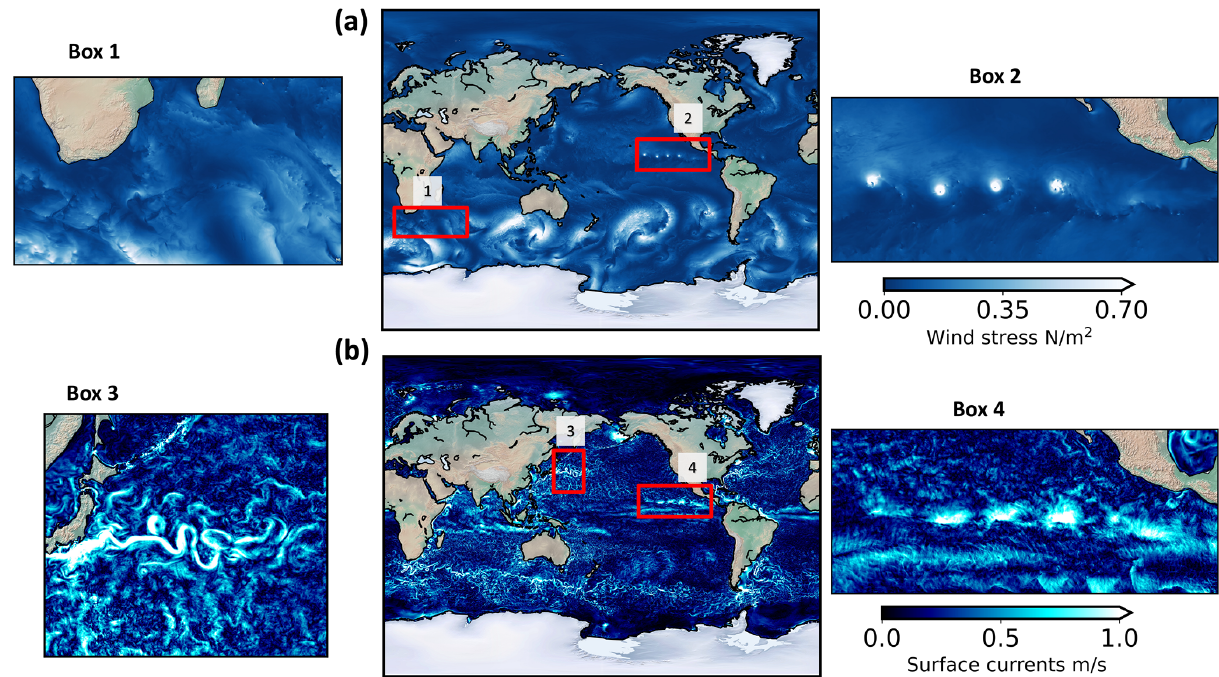
Figure 1. (a) Snapshots of surface wind stress and (b) ocean-surface currents in the coupled ocean-atmosphere simulation (COAS) on 22 July,